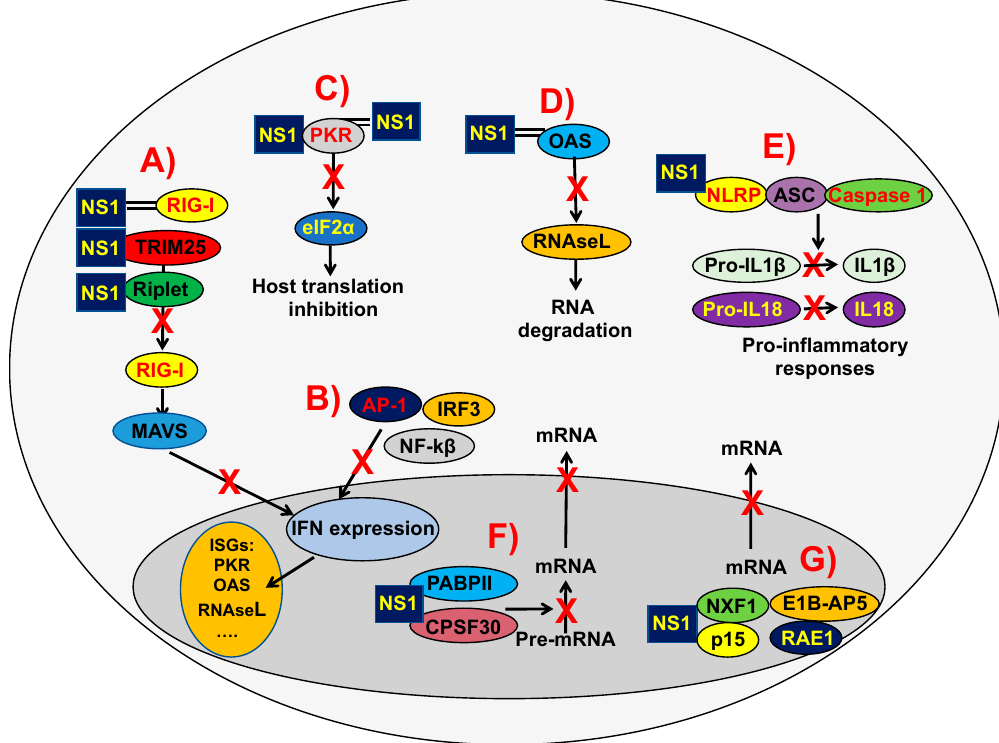
Figure 2. Direct and indirect effects of the IAV NS1 protein on innate immune responses. ( A ) IAV NS1 decreases RIG-I activation, and IFN responses, through the sequestration of dsRNA [88–90], or by interaction with TRIM25 or Riplet, which results in the suppressed ubiquitination and activation of RIG-I, which signals through the mitochondrial antiviral signaling protein (MAVS) to induce IFN responses [91,92]. ( B ) NS1 inhibits the IRF3 [99], NF- κ β [117], and AP-1 [100] transcription factors, impairing IFN production, and, therefore, the induction of IFN-stimulated gene (ISG) products. In addition, NS1 directly inhibits the antiviral activities of the ISGs PKR and OAS-RNaseL. ( C ) The IAV NS1 protein binds dsRNA and PKR, leading to decreased PKR activity to phosphorylate eIF2 α , and host translation inhibition [101–103]. ( D ) The IAV NS1 protein, via the dsRNA-binding activity of its RBD, inhibits OAS activation, blocking RNA degradation [87]. ( E ) The IAV NS1 protein also inhibits NLRP3 inflammasome activation [105–107], impairing the cleavage of pro-interleukin (IL)-1 β and pro-IL-18 into their mature forms IL-1 β and IL-18, respectively, which are released from the cell to stimulate inflammatory processes. ( F ) NS1 proteins from some human and avian IAV strains bind to CPSF30, blocking the cleavage of immature mRNAs (pre-mRNAs) and the recruitment of the poly(A) polymerase to add the poly(A) tail [62,72,74,108–110,123]. The IAV NS1 protein also binds to the poly(A)-binding protein II (PABPII), inhibiting its ability to stimulate the synthesis of long